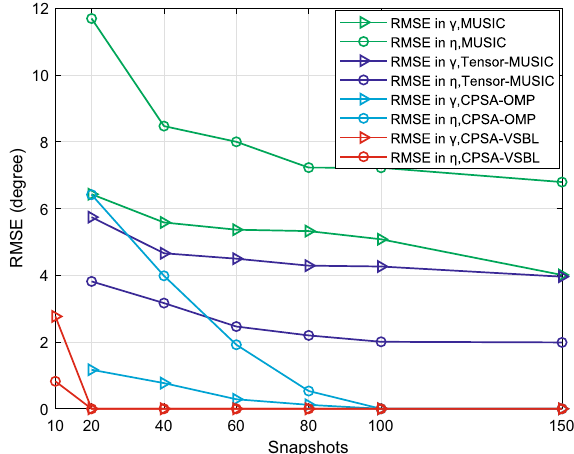
Fig. 8 The RMSE of γ and η versus number of snapshots